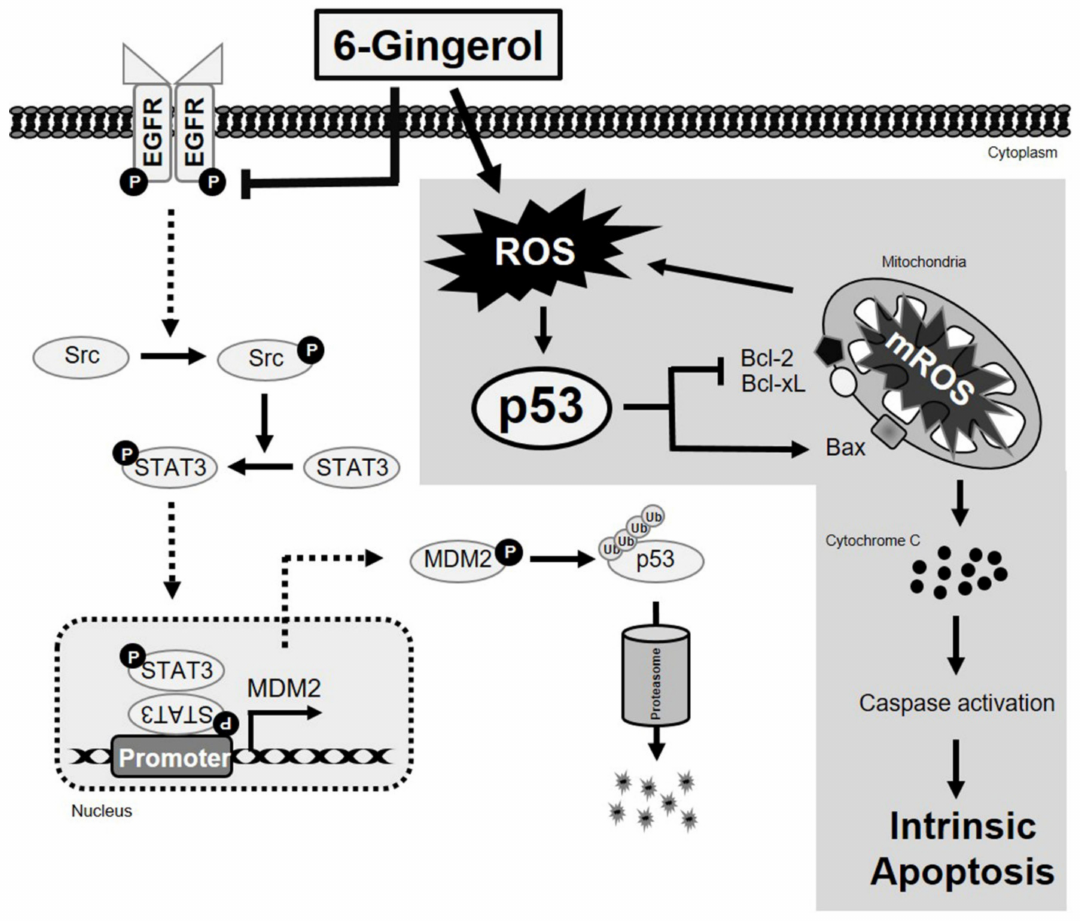
Figure 9. Molecular regulatory mechanism of p53-dependent intrinsic apoptosis by 6-gingerol in breast cancer cells and EGFR/Src/STAT3 signaling pathway inhibition by